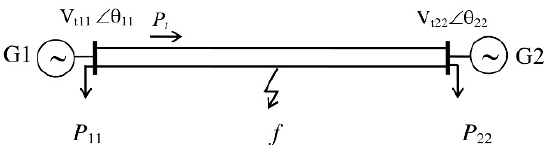
Figure 1. A two-machine power